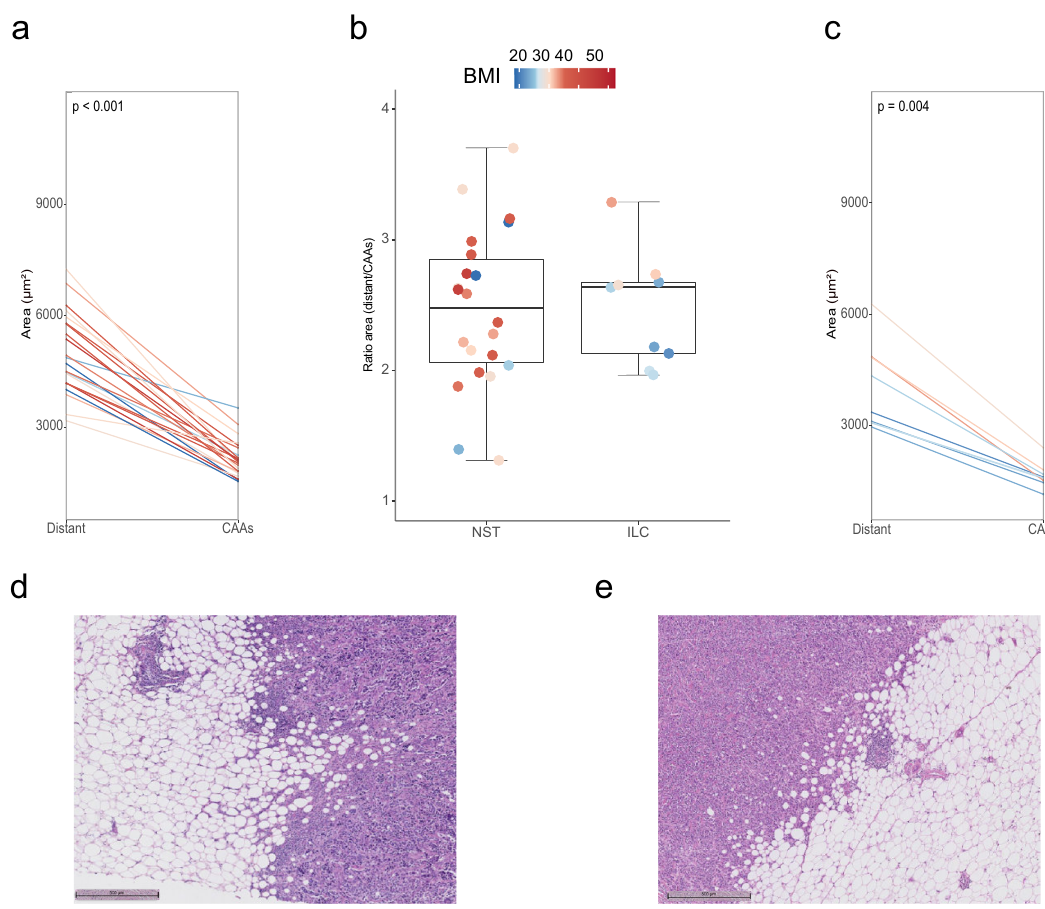
Fig. 4 Adipocyte size and histological subtypes. a , b Parallel plots show the variation of adipocytes area between distant and CAAs (left panel, NST; right panel, ILC). Each line represents a patient and is colored by ascending BMI. c Box plots show the adipocyte area ratio (distant/ CAAs). Each dot, representing a patient, is colored by ascending BMI. Box plots represent the median (bold line), interquartile range (rectangle), and the lower and upper whiskers (the two lines outside the box). d , e H&E slides showing the interaction between CAAs and cancer cells (left slide, NST; right slide, ILC). All reported P -values are from paired Wilcoxon tests. CAAs cancer-associated adipocytes, ILC invasive lobular carcinoma, NST invasive carcinoma of no special